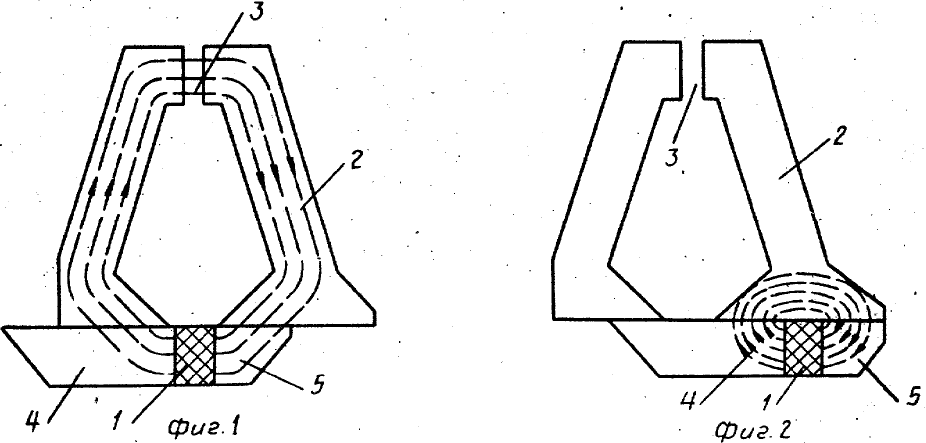
Figure 4. The scheme of mechanical regulation of magnetic field in the pole gap employing moving the additional permanent magnet relative to magnetic circuit [21]. 1 —permanent magnet, 2 —magnetic circuit, 3 —pole gap, 4 , 5 —movable part of magnetic circuit. This scheme provided a change in the magnetic field in the pole gap in the range 0.01–0.7 T.